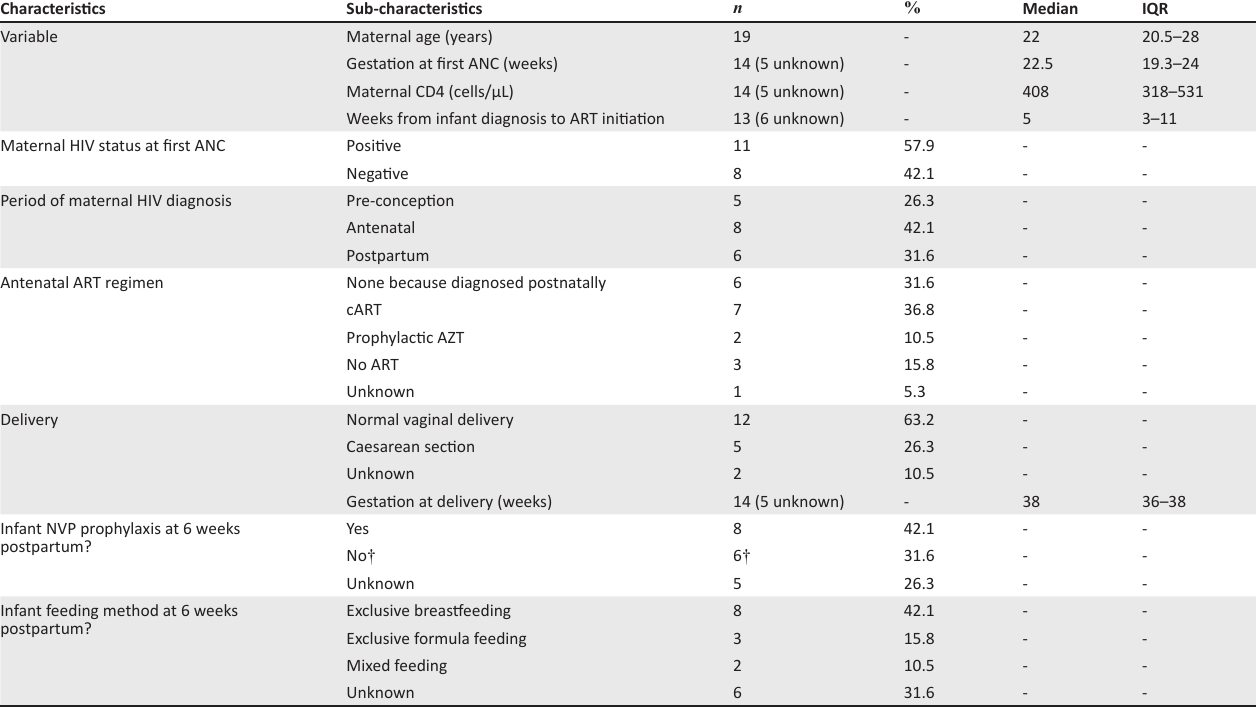
TABLE 1: Maternal and infant characteristics. Characteristics